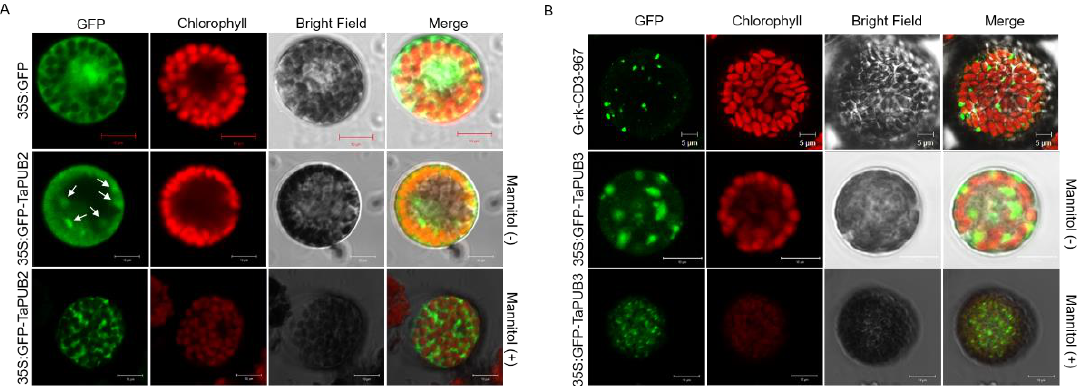
Figure 3. Subcellular localization of TaPUB2 and TaPUB3. Subcellular localization of ( A ) 35S:GFP-TaPUB2 and ( B ) 35S:GFP-TaPUB3 in wheat protoplasts. 35S:GFP and G-rk-CD3-967 were used as controls. A confocal laser scanning microscope was used to detect the fluorescence signal.